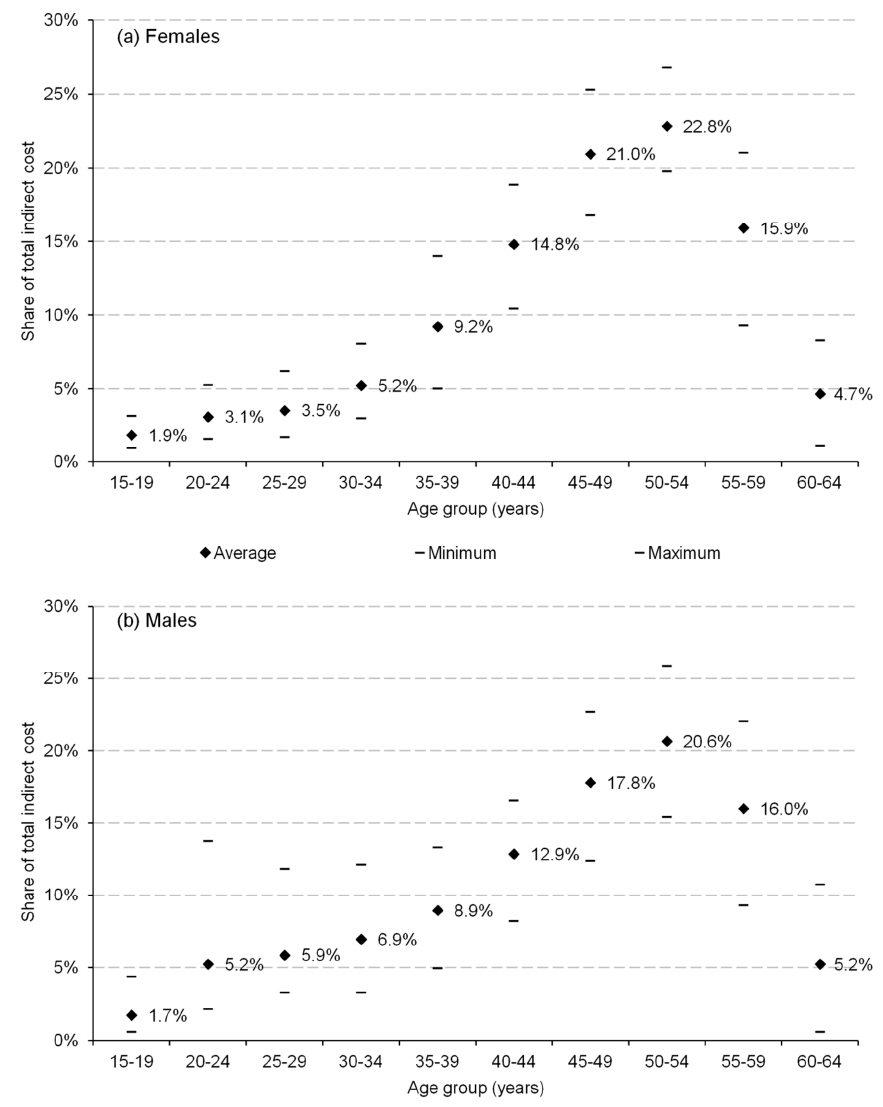
Figure 2. Agedistributionof( a )femaleand( b )maleproductionlossesassociatedwithalcohol-attributable Figure 2. Age distribution of ( a ) female and ( b ) male production losses associated with alcohol- mortality in 28 European Union countries, attributable mortality in 28 European Union countries, 2016.